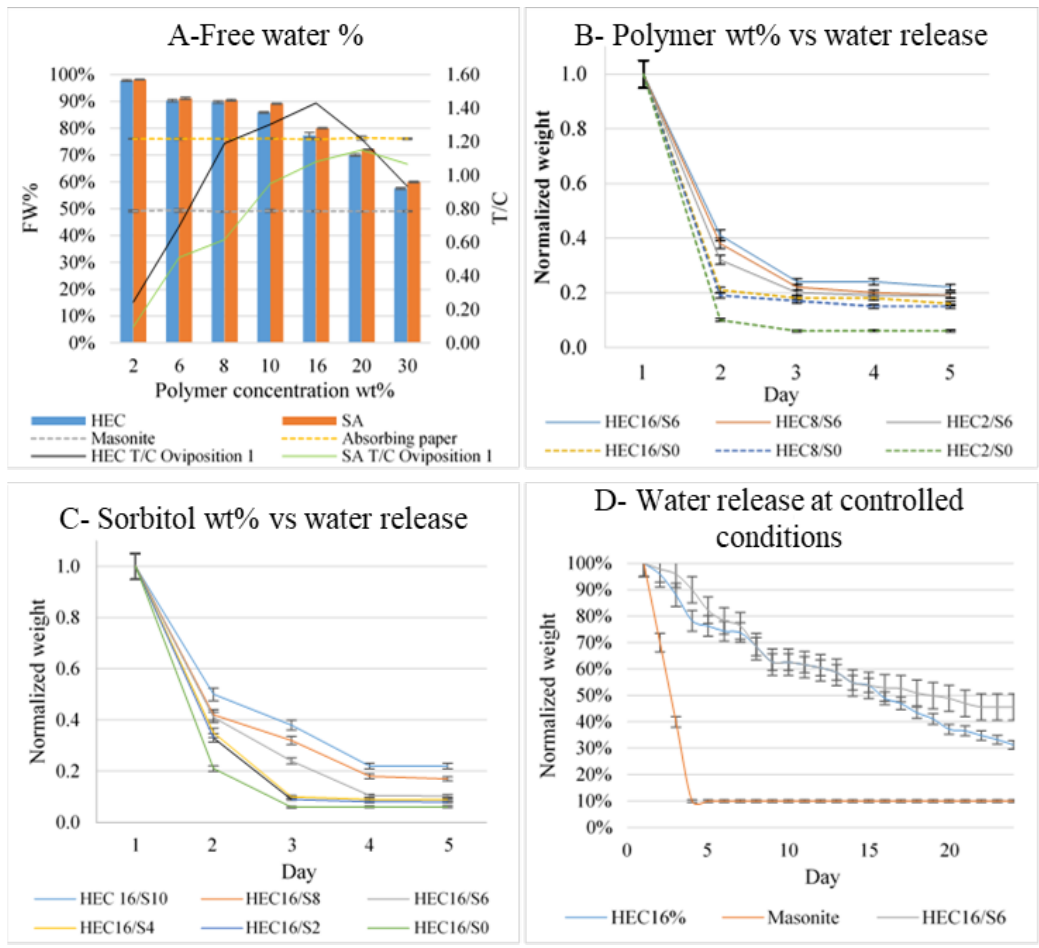
Figure 6. ( A ) Free water % values in hydrogel samples and controls compared to oviposition values curves. Water release measurement expressed through weight values variations with time: ( B ) Water release vs. Polymer and Sorbitol wt% and ( C ) Water release vs. Sorbitol wt%. ( D ) Water release at controlled conditions in climatic chamber 25 °C, 80% RH. All results are expressed as value ± SD.